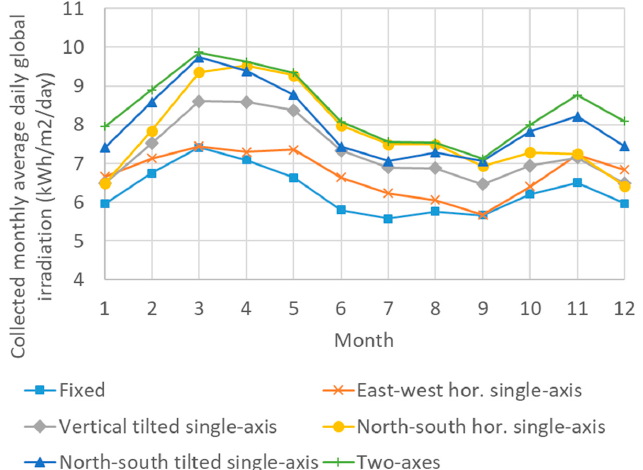
Figure 2. Ideal collected global irradiance of the different types of sun trackers over the winter ( a ) and summer ( b ) solstices in Aguascalientes, and comparison to a south-oriented fixed structure system with tilt equal to latitude. Table 1. Daily collected irradiation and percentage gains relative to a south-oriented fixed structure system with tilt equal to latitude of the different types of sun trackers for the winter and summer solstices in Aguascalientes.